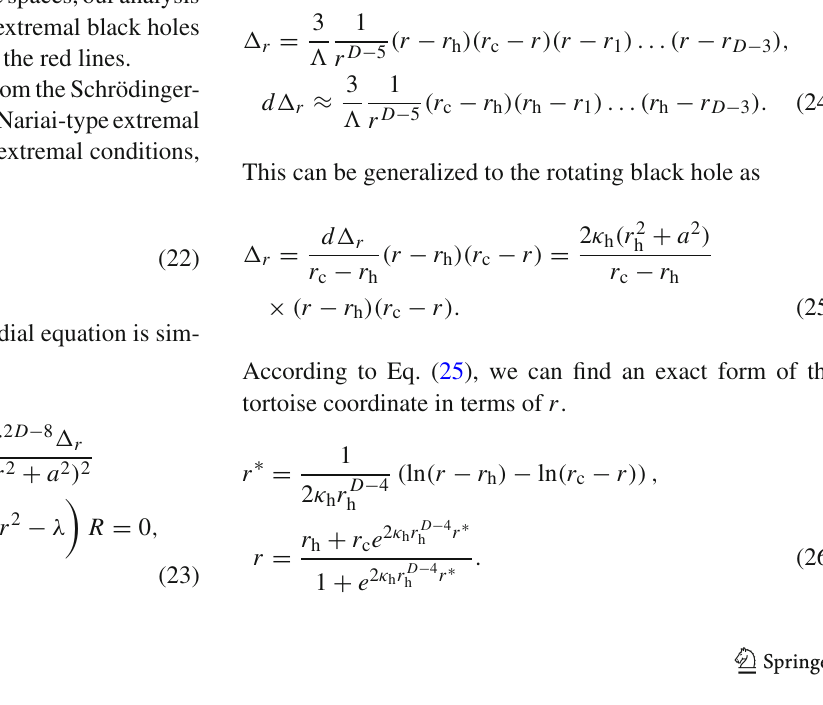
is no Kerr-extremal black hole of r i = r h . Instead, there is a maximum spin parameter where the black hole can